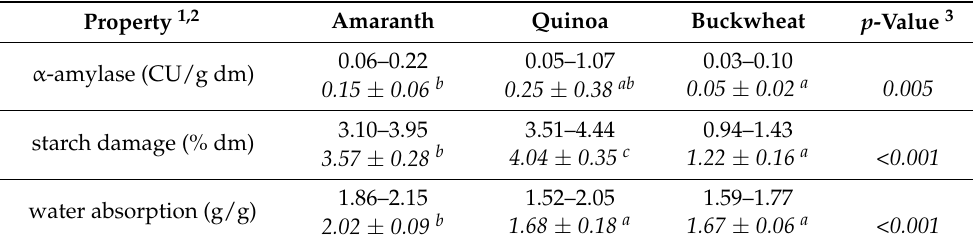
Table 9. Level of α -amylase and starch damage, and water absorption of amaranth ( n = 8), quinoa ( n = 7) and buckwheat ( n = 10) wholemeal